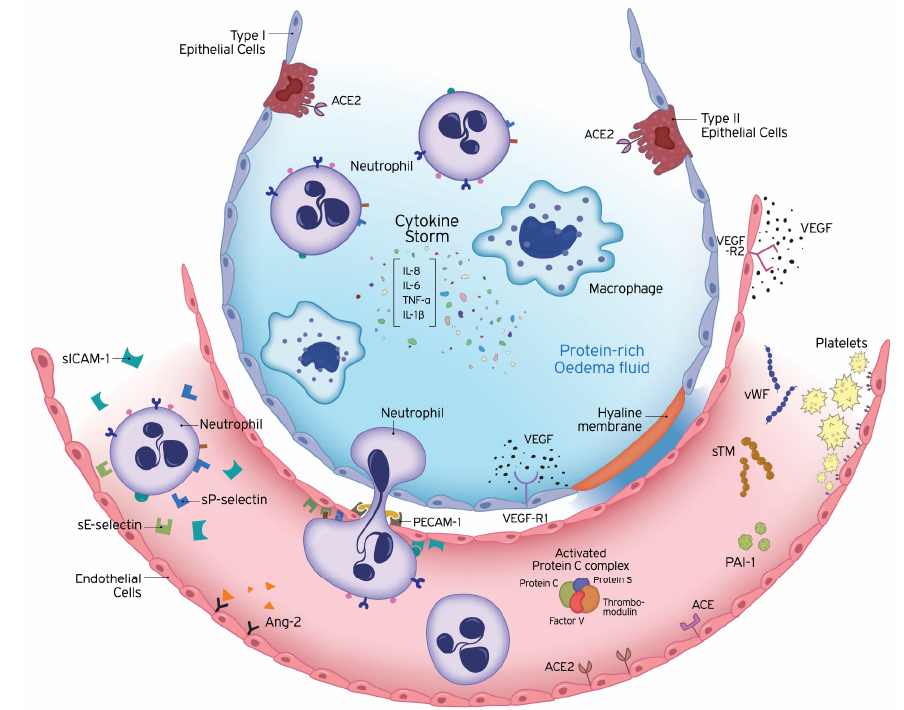
Figure 1. Underlying pathology of endothelial dysfunction leading to acute respiratory distress syndrome (ARDS). ARDS is characterized by damage to the capillary endothelium and alveolar epithelium. Disruption of the endothelial barrier results in the movement of fluid and macromolecules into the interstitial space and pulmonary air spaces causing pulmonary oedema. The formation of a hyaline membrane in alveolar walls allows exudation of neutrophils and protein-rich fluid into the alveolar space. Transport across the endothelium can occur either via the endothelial cell (transcellular) or between adjacent cells, through inter-endothelial junctions (IEJs) (paracellular). The changes in the microvascular endothelial structure and function play a central role in the acute inflammatory response, in which the body tries to eliminate microbial invaders. To achieve this, the endothelium becomes leaky and inflamed, allowing innate immune cells and humoral e ff ector molecules to cross the barrier to the site of infection. This defence mechanism may become deleterious, under overwhelming pathological conditions, leading to ARDS. The cells of the innate immune system release large amounts of pro- and anti-inflammatory cytokines, such as IL-1 β , IL-6, IL-8, and TNF- α . The high levels of circulating cytokines can potentiate organ damage by endothelial injury and other routes. Endothelial damage is associated with activation of neutrophils and expression of neutrophil and endothelial adhesion molecules. E-selectin and P-selectin are early mediators of the adhesion of activated neutrophils to endothelia in inflammatory states, prior to their firm adhesion and diapedesis at sites of tissue injury and inflammation. Intercellular adhesion molecule-1 (ICAM-1) controls the firm adhesion of neutrophils on the endothelium and facilitates their subsequent transendothelial migration via the platelet-endothelial cell adhesion molecule-1 (PECAM-1) to infection sites. In addition to inflammation, coagulation and fibrinolysis are also critical host responses to infection and injury involved in ARDS. Endothelial cells (ECs) coordinate this response by shifting from their normal anti-thrombotic, anti-inflammatory, and pro-fibrinolytic phenotype to an activated state of endothelial dysfunction. ECs actively regulate haemostasis by producing a variety of proteins, including pro-thrombotic substances (von Willebrand factor, P-selectin), molecules restricting coagulation (thrombomodulin) and fibrinolytic factors (plasminogen activators). Plasminogen activator inhibitor-1 (PAI-1) is the major inhibitor of fibrinolysis, whose upregulation leads to a shift from pro- to anti-fibrinolytic phenotypes. The protein C (PC) system provides important control of coagulation by virtue of the capacity of activated protein C (APC) to proteolytically inactivate the cofactors Va and VIIIa. The PC anticoagulant system also involves protein S, and the endothelial receptor thrombomodulin (TM). Conversion of protein C to